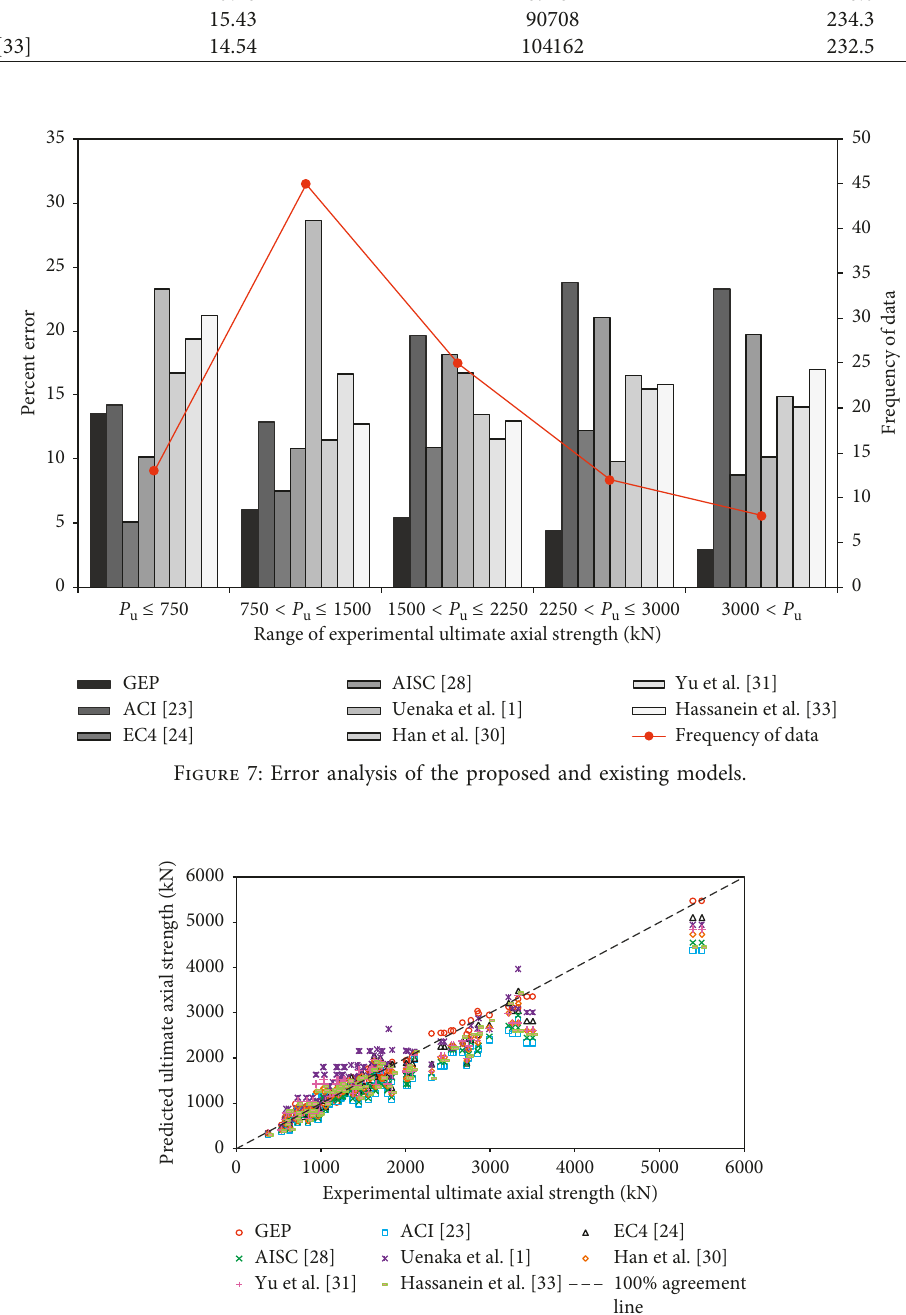
Figure 8: Comparison of the proposed model with the existing ones.